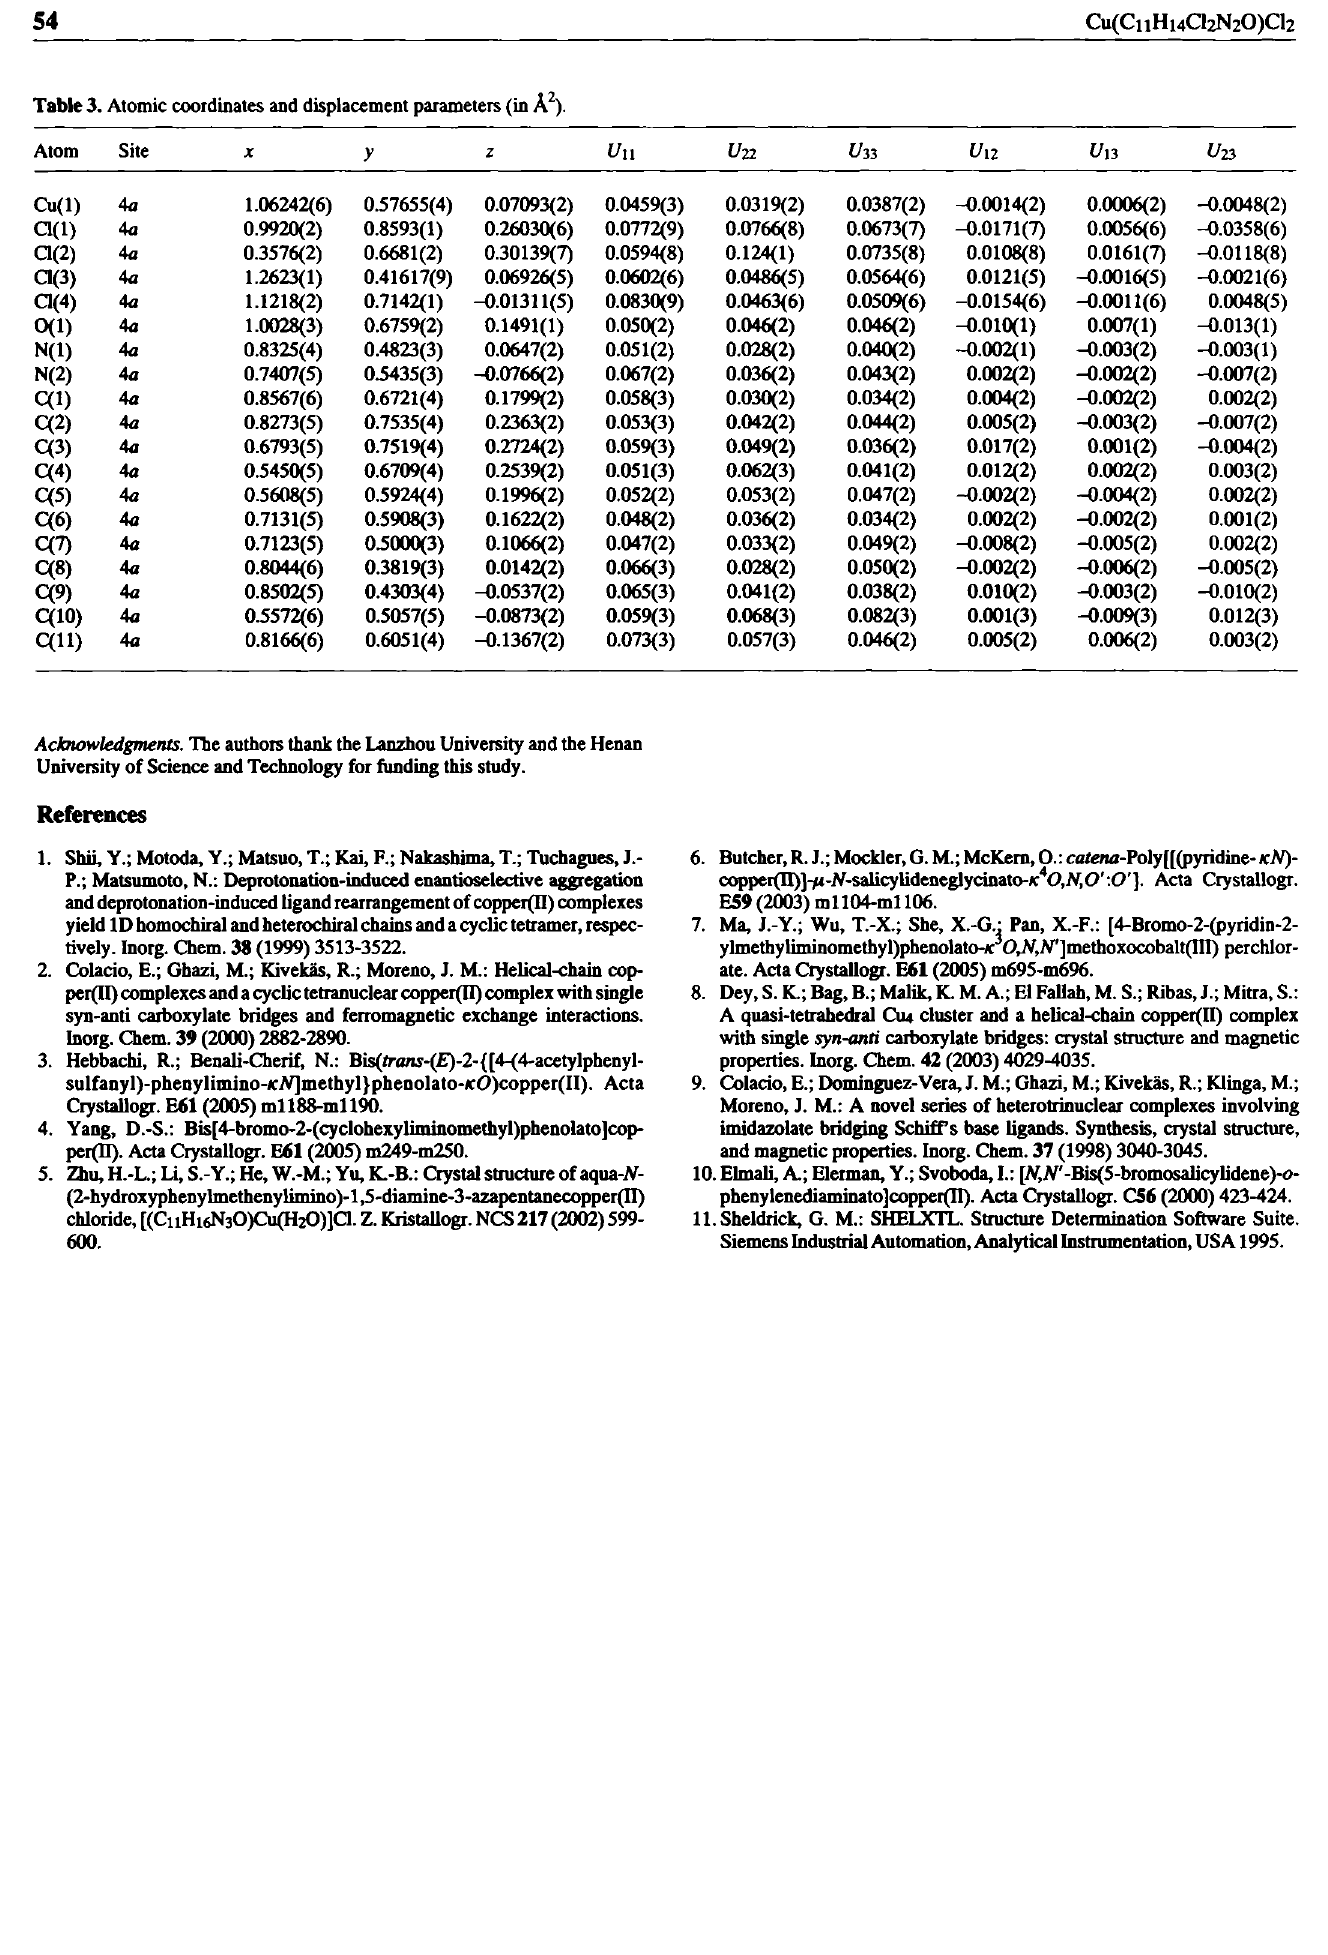
Table 3. Atomic coordinates and displacement parameters (in A 2